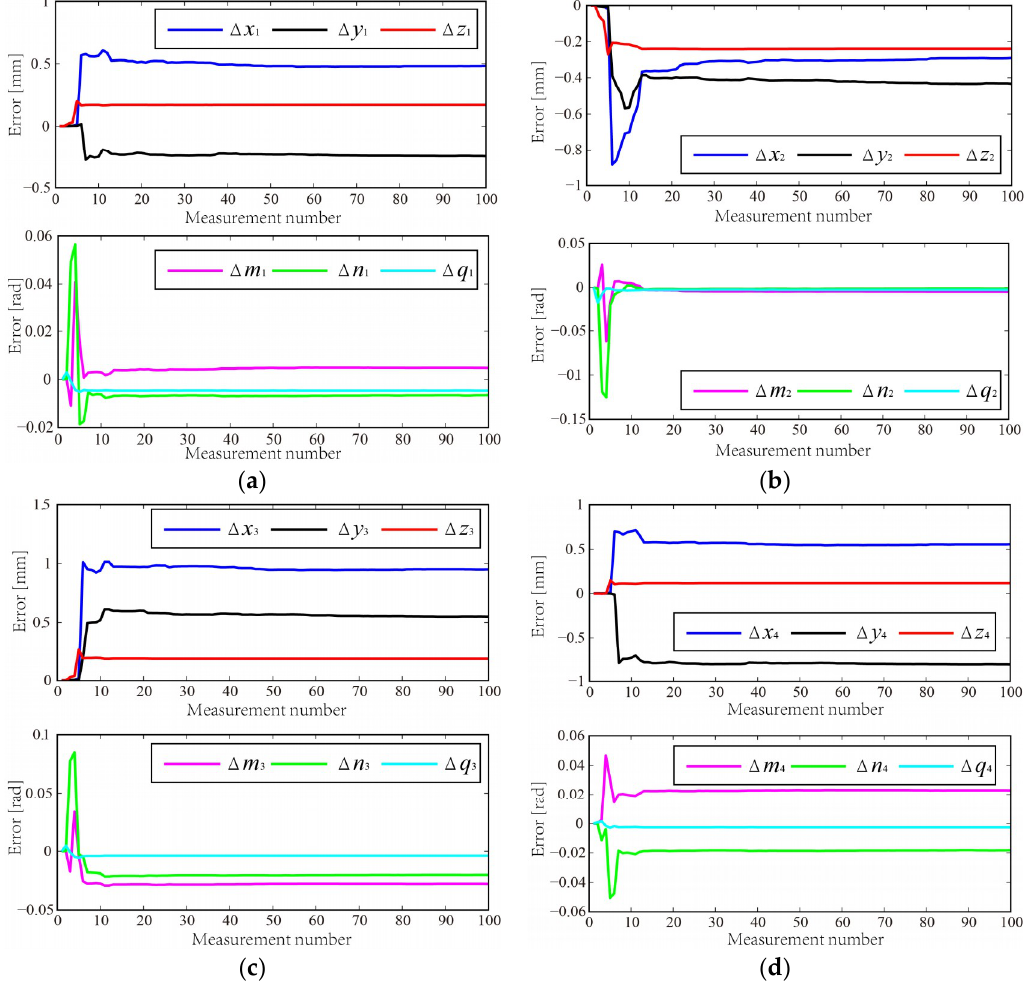
Figure 11. Estimated parameter errors of sensors using EKF algorithm. Table 7. The numbers of convergence measurement points for each laser.